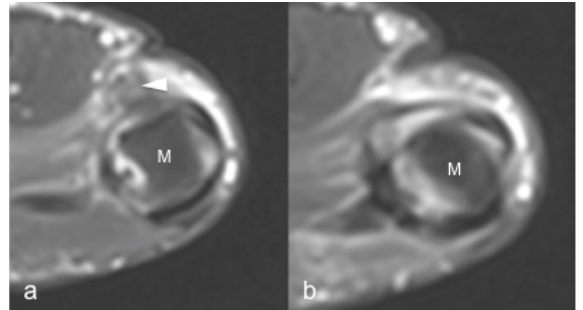
Figure 7. Full-thickness UCL tear. In ( a ), normal appearance of adductor pollicis aponeurosis (white arrows) and below the ulnar collateral ligament (asterisk) of the first metacarpophalangeal joint. In ( b ), the non-visualization of the ulnar collateral ligament and the presence of a mass-like area (arrowhead) proximal to the joint have high accuracy in depicting a displaced full-thickness ligament tear.